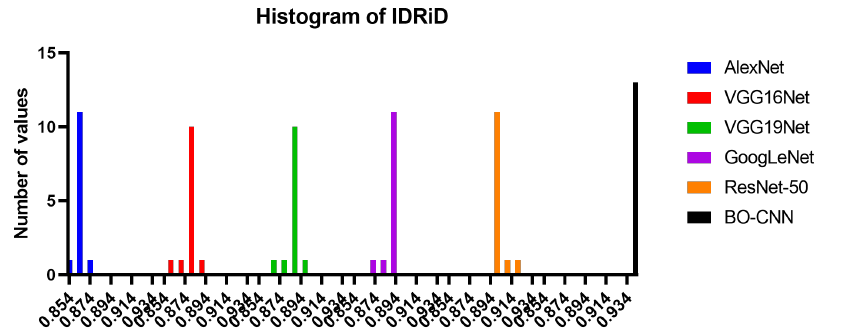
Figure 15. Histogram of the proposed BO-CNN model vs. pre-trained-CNN models for the IDRiD dataset based on number of values.